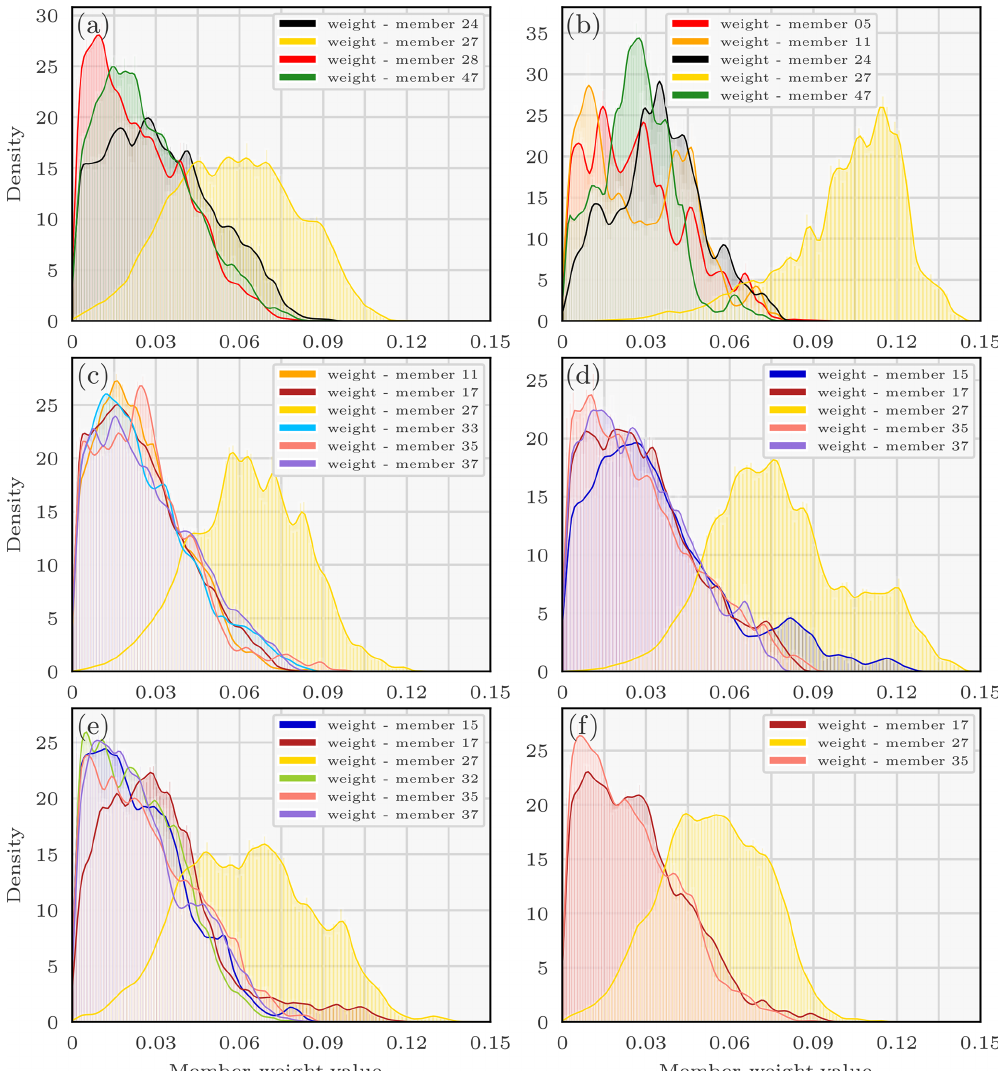
Figure 8. Densities of the weights of the members of the enhanced ensemble using the parallel tempering method and the observation-sorting algorithm for diverse likelihoods: log-normal with threshold 0.5 (a) , log-normal with threshold 3 (b) , log-Laplace with threshold 0.1 (c) , log- Laplace with threshold 0.5 (d) , log-Cauchy with threshold 0.1 (e) , log-Cauchy with threshold 0.3 (f) . L-L means log-Laplace, L-n means log-normal, L-C means log-Cauchy, and y t is the likelihood threshold. Only densities with high medians are